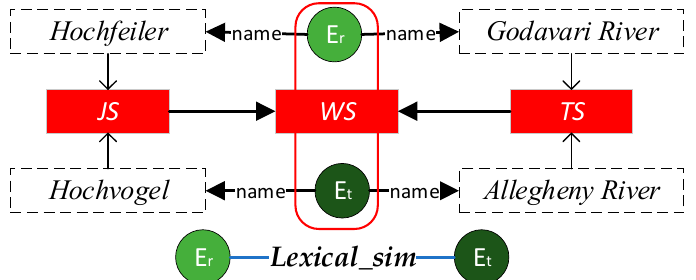
Figure 3. Lexical similarity calculation schemes.